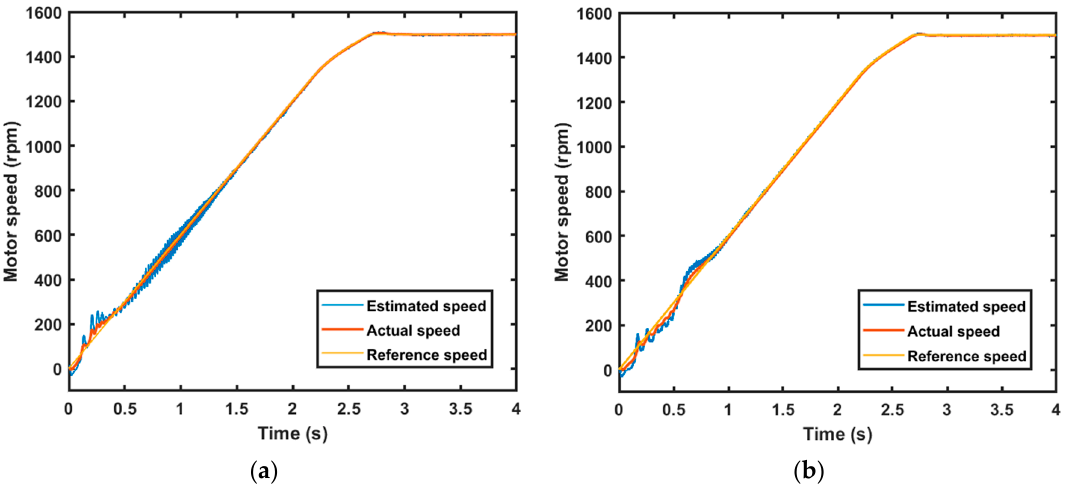
Table 1. Motor parameters.